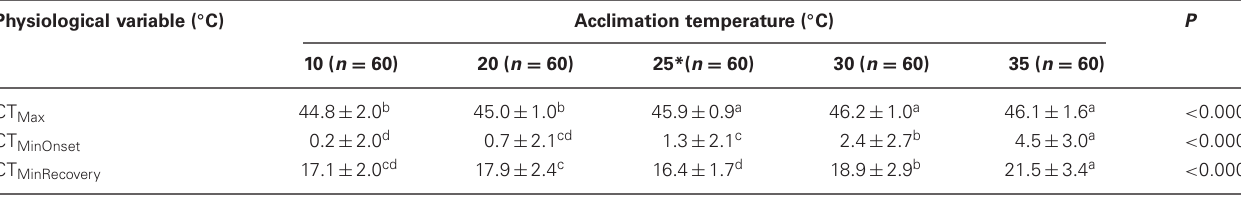
Table 1 | Physiological variation of Nezara viridula (L.) in culture room and laboratory temperature acclimation. Physiological variable ( ◦